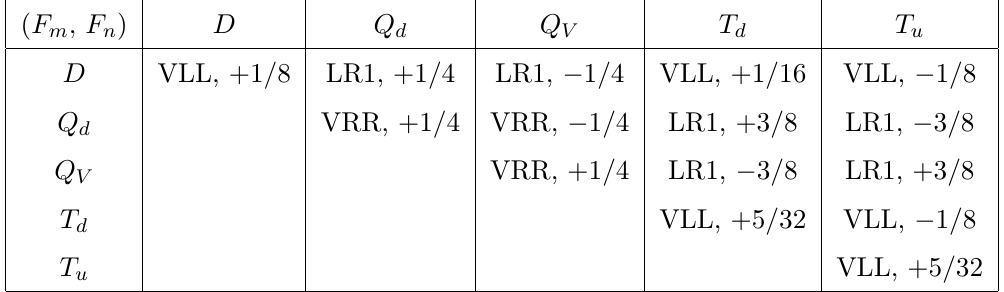
Table 5. The index a = VLL ; VRR ; LR1 appearing in eq. (3.18) for representations ( F m ; F n ), followed by corresponding (cid:17) mn